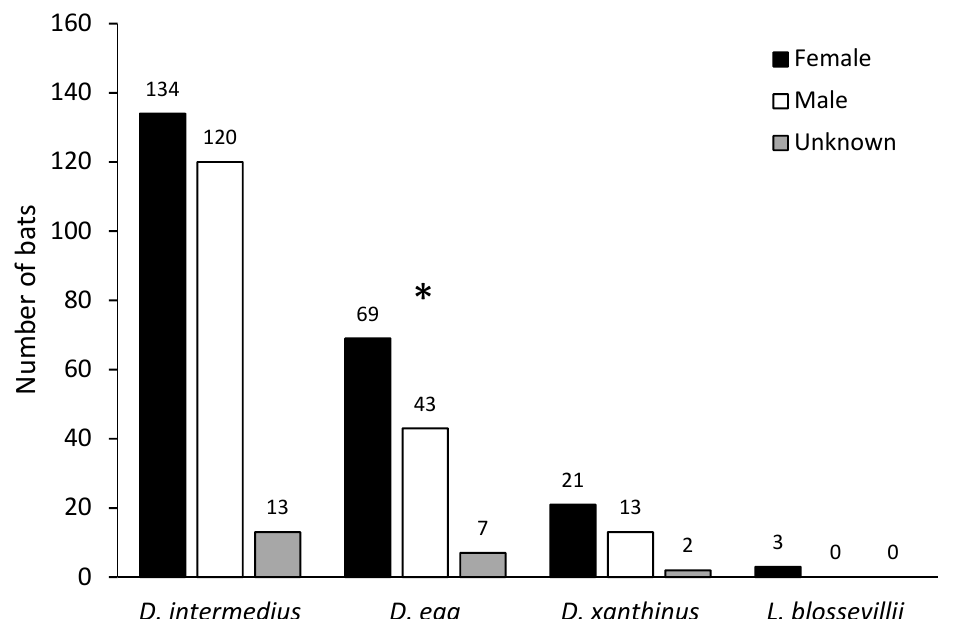
Figure 4. Number of individual bats from each species identified as female, male, or sex unknown using molecular methods. The star above D. ega indicates a significant deviation from a 50:50 sex ratio (Fisher’s exact test: p = 0.018).